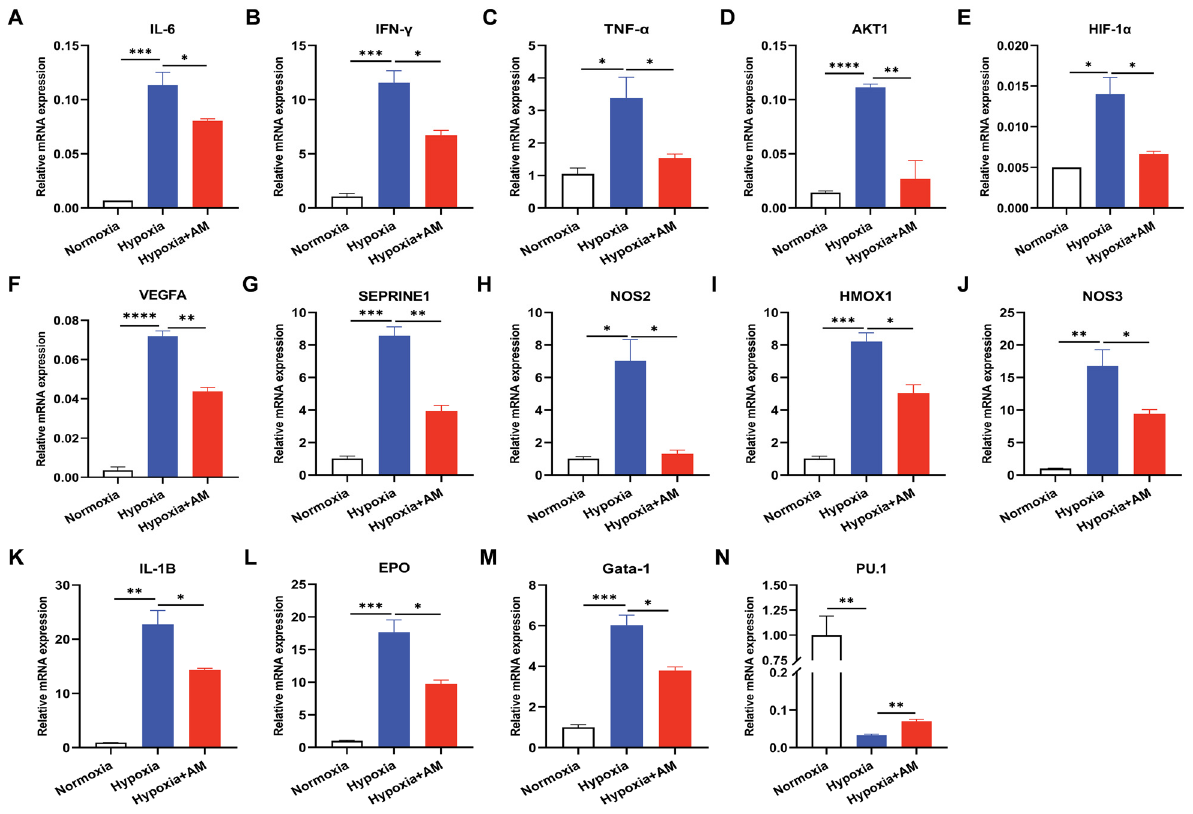
Figure 11. AM decreased erythropoiesis by regulating the HIF-1 pathway. ( A – N ) qRT-PCR was used to assess the differential expression of IL-6 ( A ), IFN- γ ( B ), TNF- α ( C ), AKT1 ( D ), HIF-1 α ( E ), VEGFA ( F ), SEPRINE1 ( G ), NOS2 ( H ), HMOX1 ( I ), NOS3 ( J ), IL-1B ( K ), EPO ( L ), Gata-1 ( M ), and PU.1 ( N ) mRNA in BM from various groups. n = 4. * p < 0.05; ** p < 0.01; *** p < 0.001; **** p < 0.0001. Compared with the Hypoxic group.